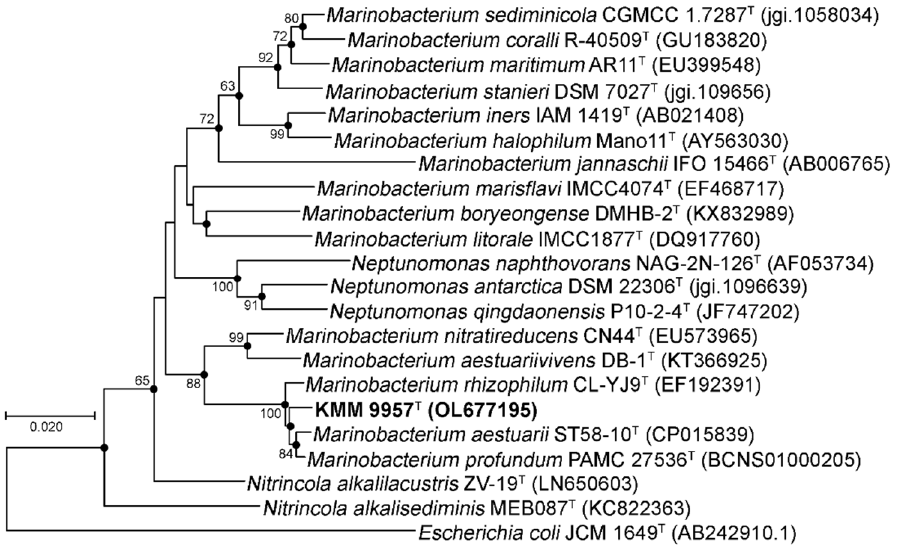
Figure 1. Neighbor-joining tree based on 16S rRNA gene sequences available from the Gen- Bank/EMBL/DDBJ databases (accession numbers are given in parentheses) showing relationships of the novel strain KMM 9957 T and Marinobacterium species. Filled circles indicate the corresponding nodes that were observed in the maximum-likelihood tree. Numbers indicate bootstrap values as percentage greater than 60. These values are based on 1000 replicates. Bar, 0.020 substitutions per nucleotide position.